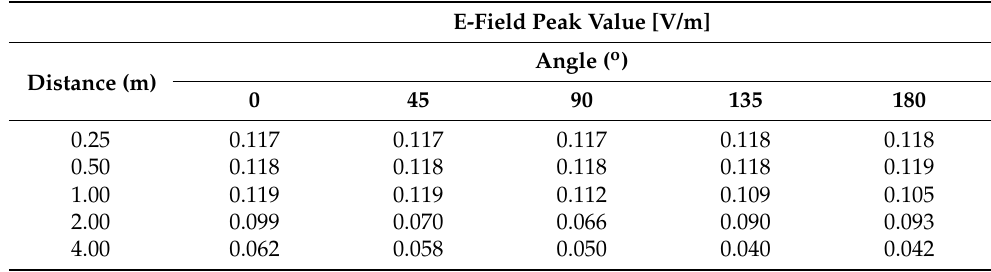
Table 5. The E-field measurements results obtained near the MO-RFID reader: frequency—866 MHz, location—HUC, Torre Norte 4